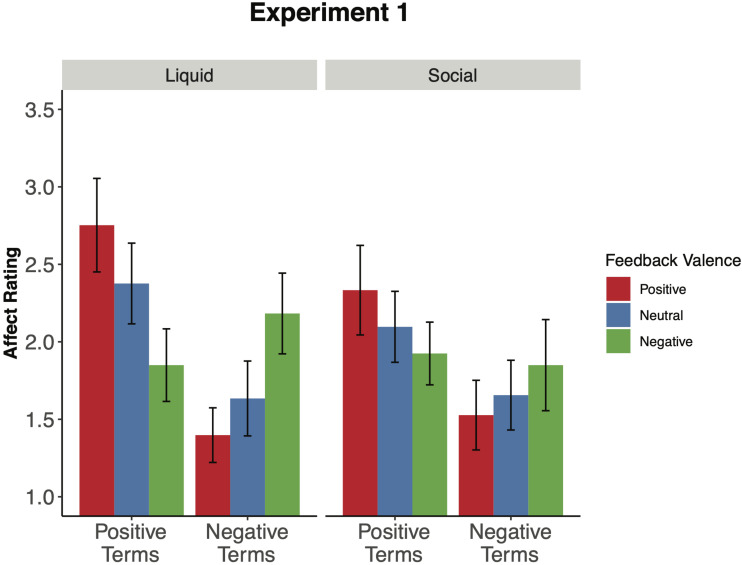
Affect ratings by experimental manipulation (Experiment 1). This figure illustrates the mean affect rating for each incentive condition across both liquid and social feedback sessions. Participants rated the extent to which they were feeling each of the emotion words after each block of the cued task-switching paradigm using a five-point scale (e.g., 1-not at all, 5-extremely). Positive affect represents the average ratings across the following terms: “content,” “inspired,” and “excited.” Negative affect represents the average ratings across the following terms: “ashamed,” “irritable,” and “upset.” Error bars signify 95% confidence intervals around the mean.